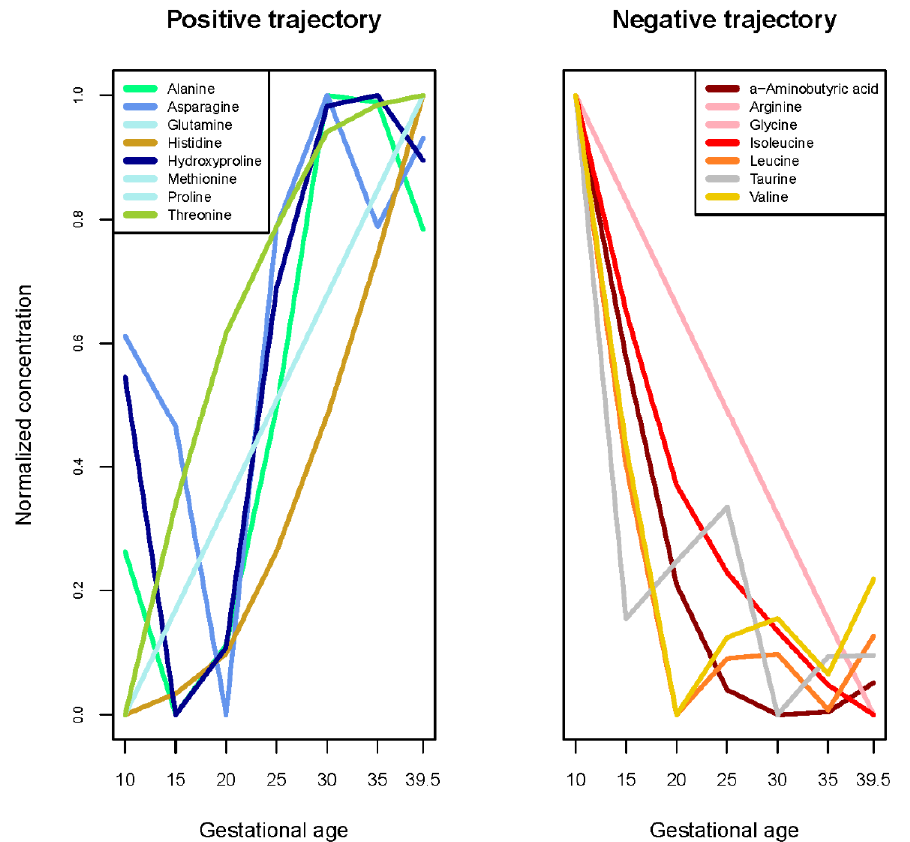
Figure 3. Trajectories of normalized amino acid concentrations, estimated from linear mixed models with 5-knot penalized splines. Amino acids with positive and negative trajectories were identified using slopes from linear mixed models. Metabolites with the same trajectory are plotted with the same color as a single line. Absolute concentrations of each amino acid ( n = 25) are plotted in the Supplemental Material.